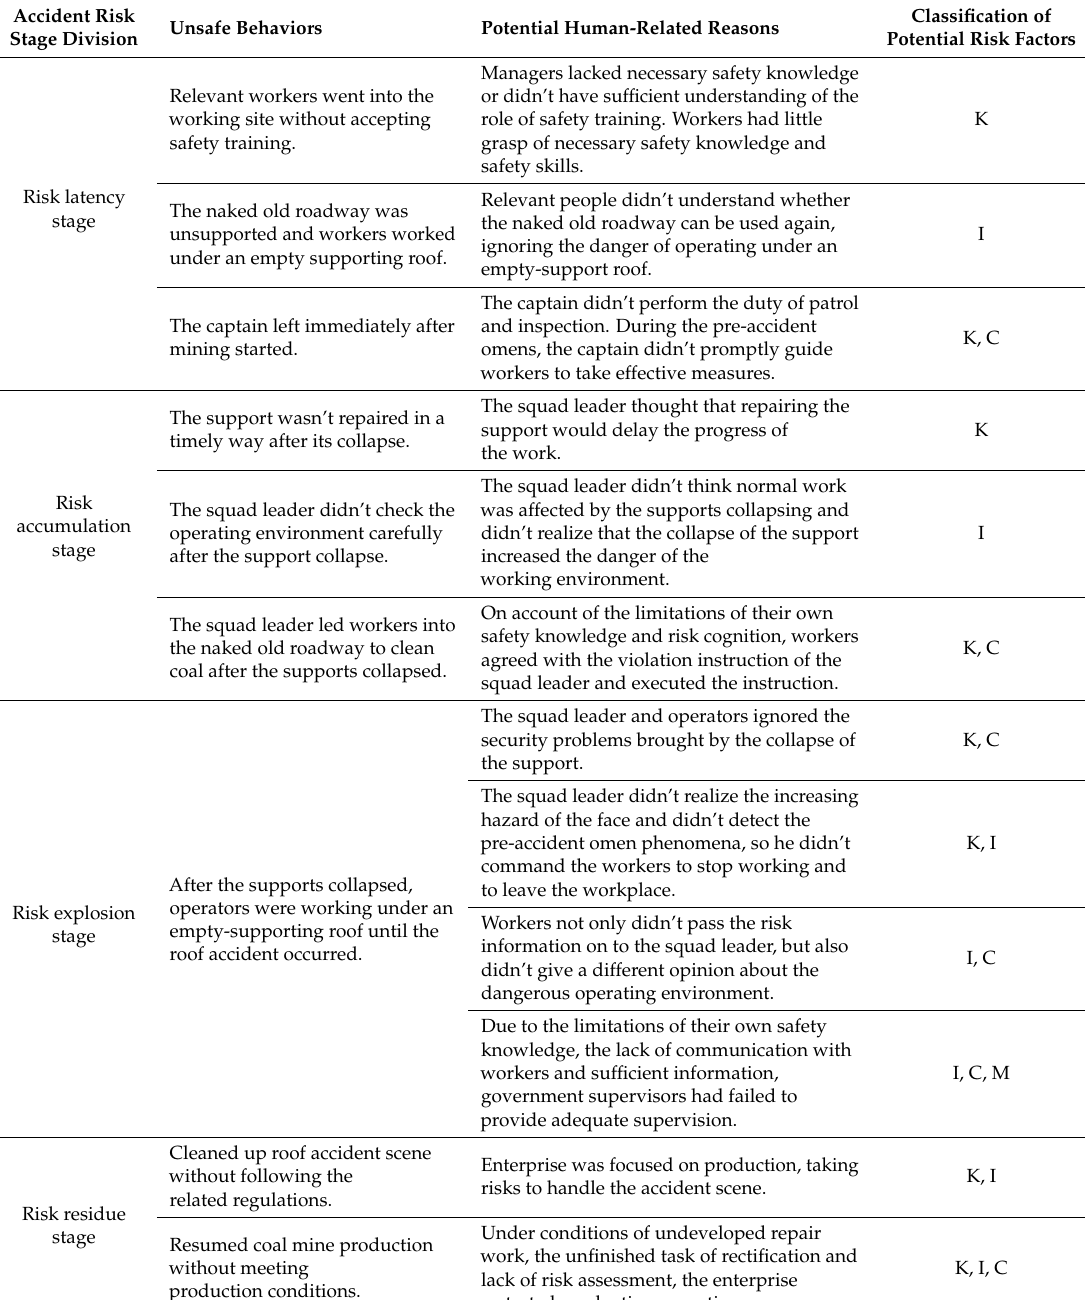
Table 2. Development analysis on the “4-24” major roof